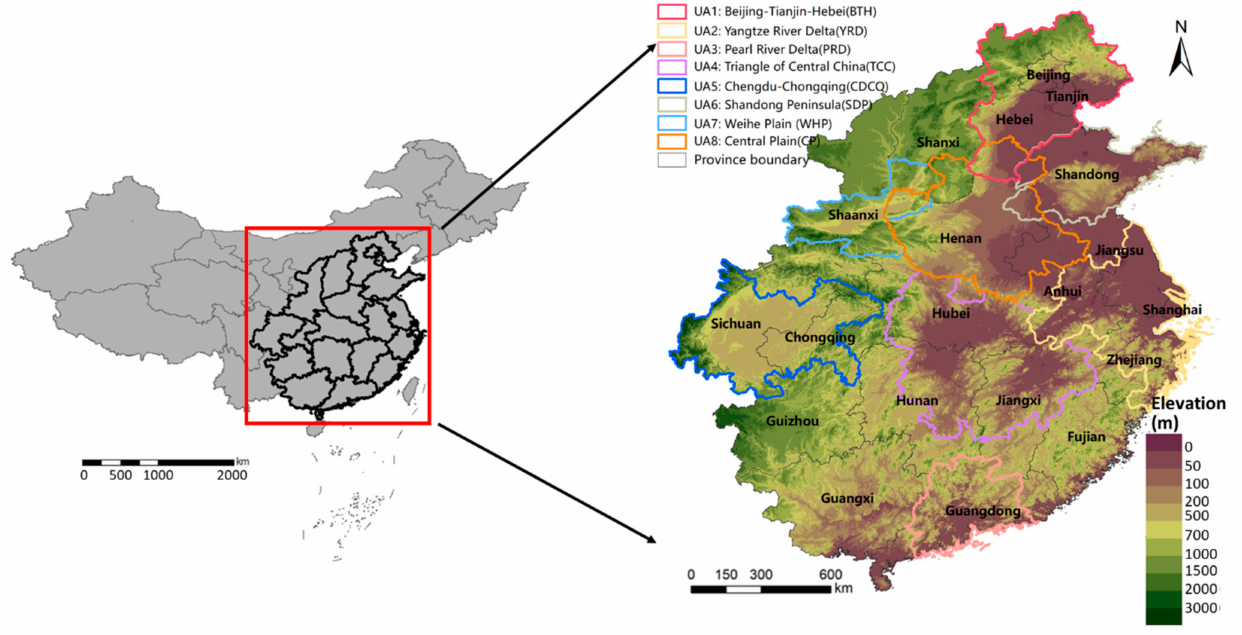
Figure 1. Study region of the present work, showing the eight urban agglomerations and